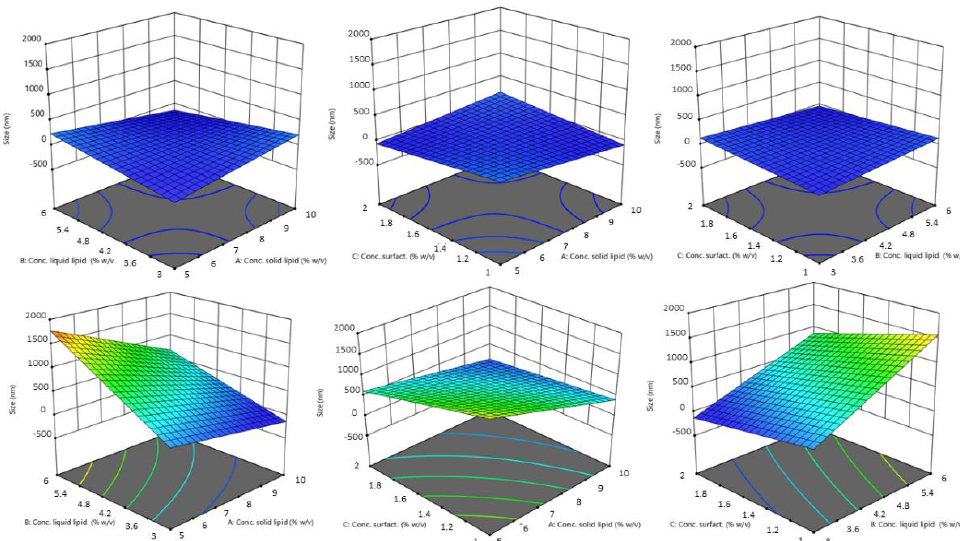
Figure 3. 3D surface model of the effect of independent variables (from left to right: solid lipid concn. vs. liquid lipid concn., solid lipid concn. vs. surfactant concn., and liquid lipid concn. vs. surfactant concn.) on the size of NLCs using Softisan ® 100 (top) and Gelucire ® 44/14 (bottom row).